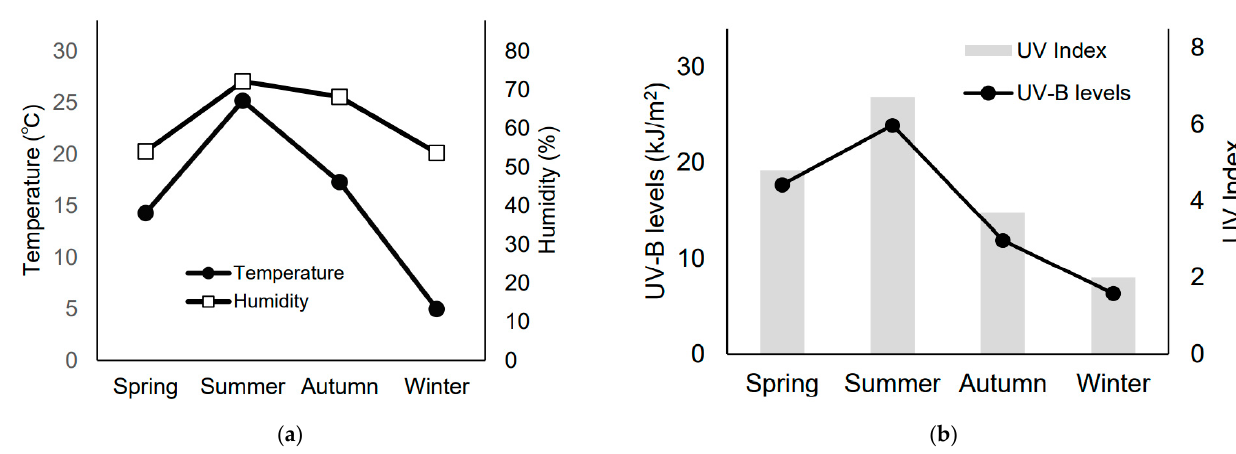
Figure 1. Observational data in different Japanese seasons. ( a ) The average ambient temperature (°C; left axis) and average humidity (%; right axis) (Maebashi, 2014–2019). Modified from “Historical weather data” with permission from the Japan Meteorological Agency. ( b ) The average ultraviolet (UV)-B levels (kJ/m 2 ; left axis) and average UV index (right axis) (Tsukuba, 2014–2019). Modified from “UV data collection” with permission from the Japan Meteorological Agency.